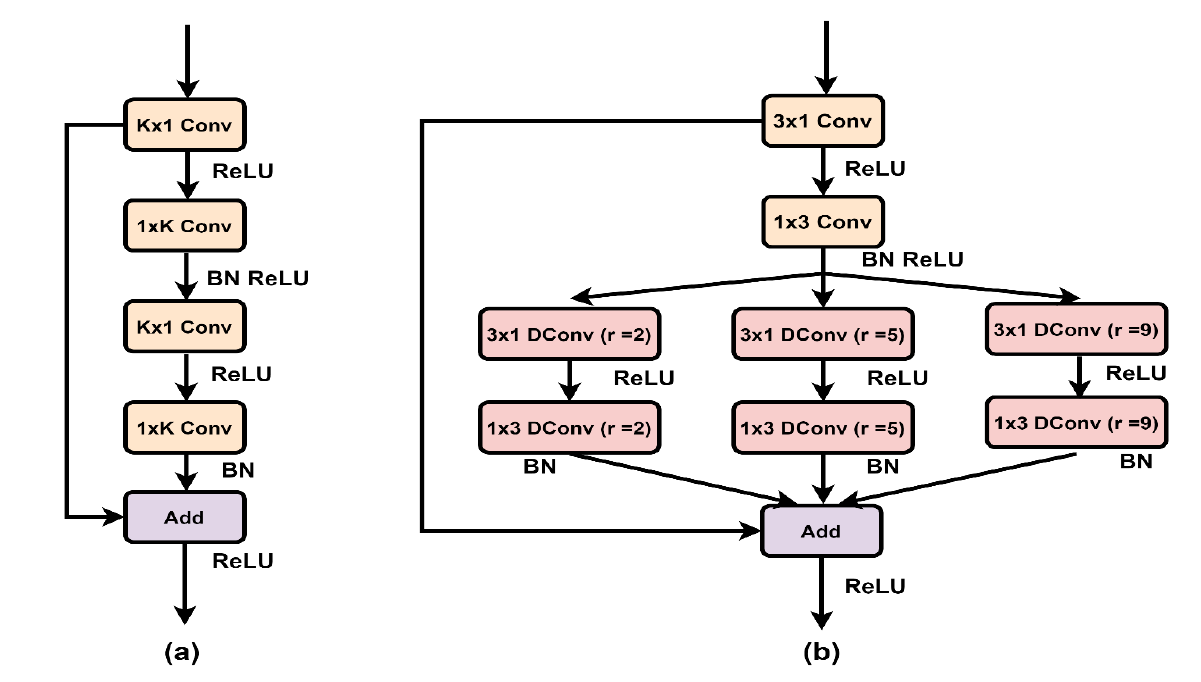
Figure 4. Structure of ( a ) FCU block and ( b ) PFCU block.